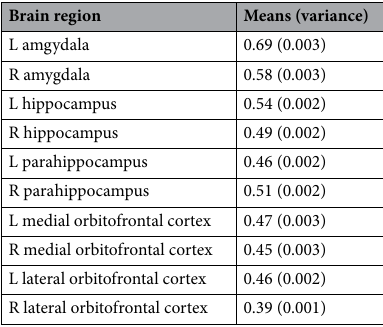
Table 2. Gray matter volumes, reported as proportion of gray matter within each